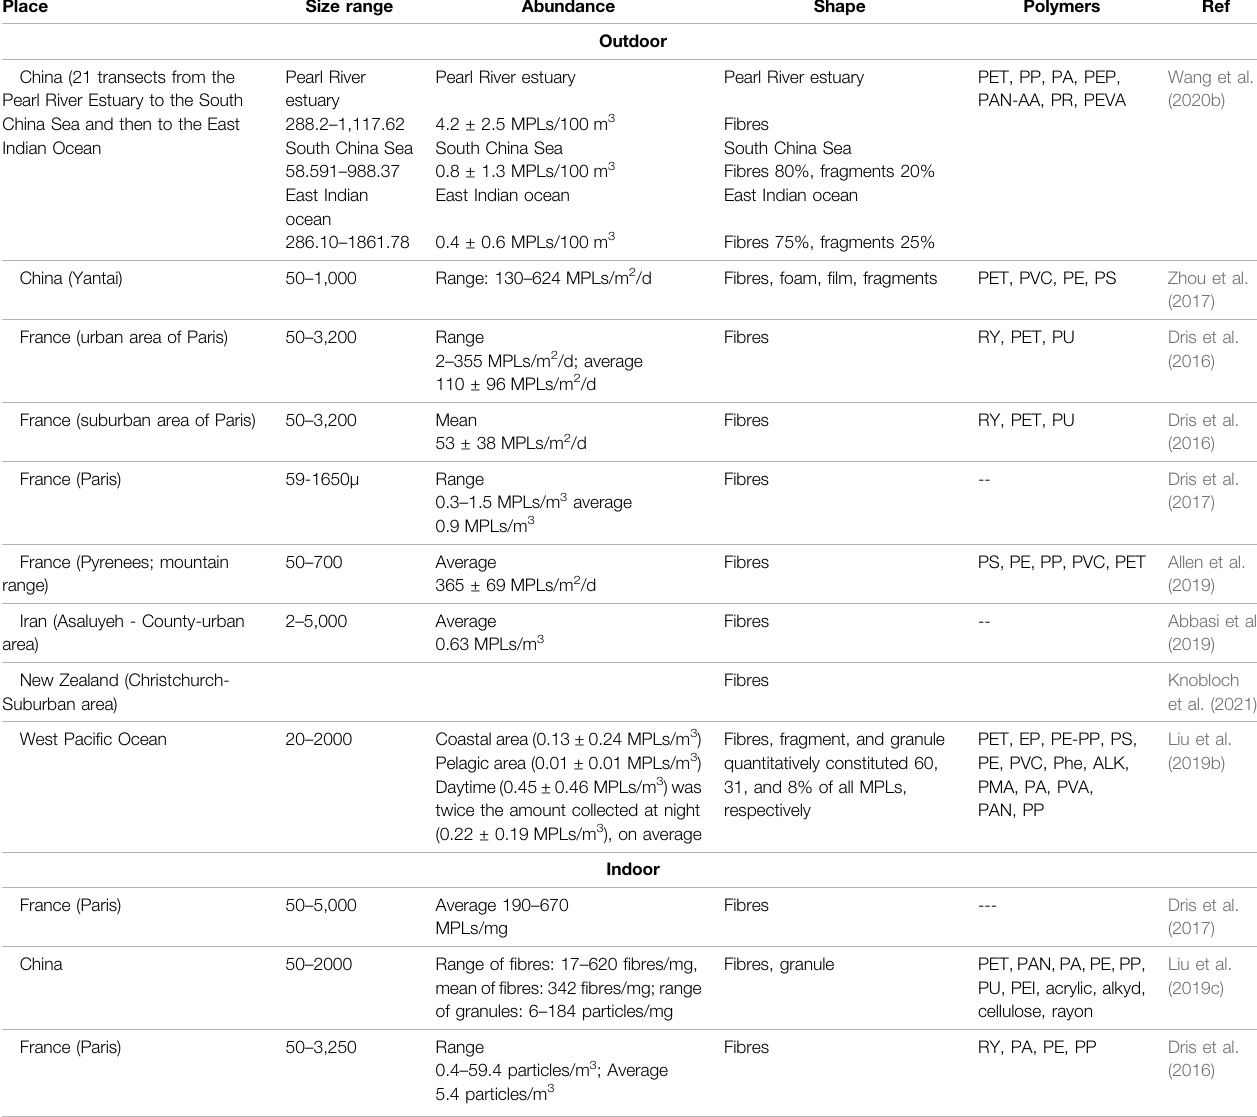
TABLE 2 | Summary of studies assessing MNPLs in airborne particulate and atmospheric deposition.